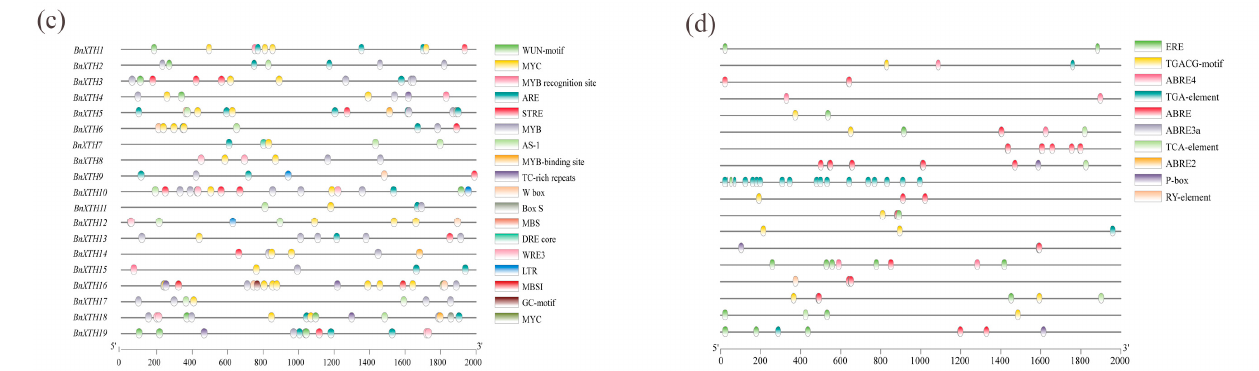
Figure 5. Prediction of cisregulatory elements of BnXTHs . ( a ) The number of cisregulatory elements in BnXTH promoters. ( b ) The number of cisregulatory elements involved in the responses to abiotic and biotic stress, phytohormone signaling, and plant growth and development. ( c ) Type, quantity, and position of the ciselements of BnXTH promoters in response to biotic and abiotic stress. ( d ) Type, quantity, and position of the ciselements of the BnXTH promoters in response to phytohor- mone signaling.